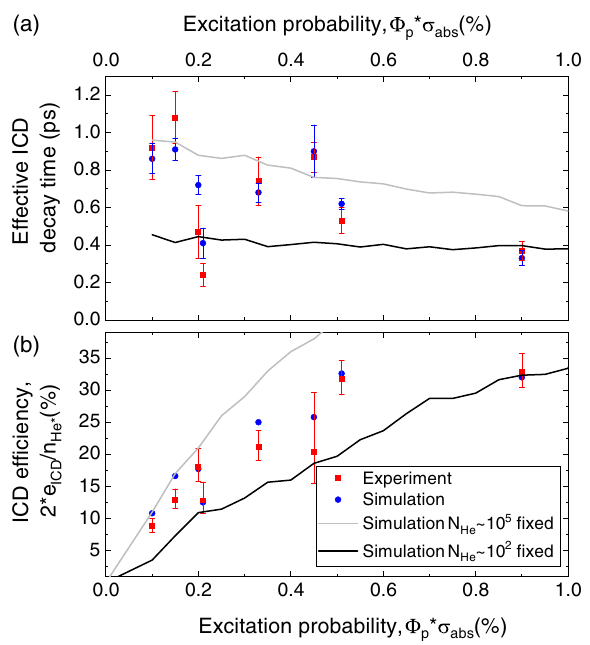
FIG. 3. (a) Effective ICD decay time and (b) ICD efficiency plotted as a function of the excitation probability (red squares). MC simulation results for the specific experimental conditions, droplet size, and FEL intensity are shown as blue dots. Addi- tionally, to show the general trend in the simulations on the FEL intensity, the results for fixed small and large droplets are shown as black and gray lines,